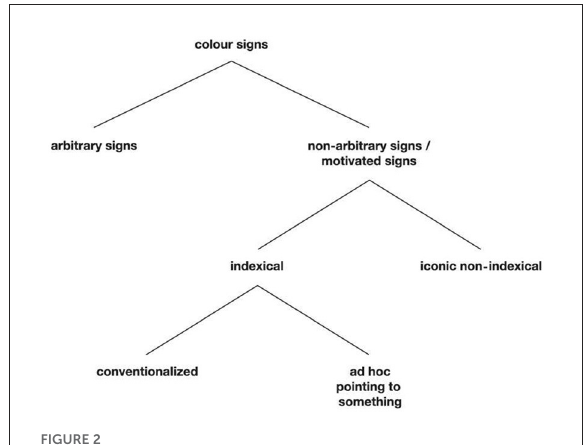
FIGURE2 Content-biased categories to represent color